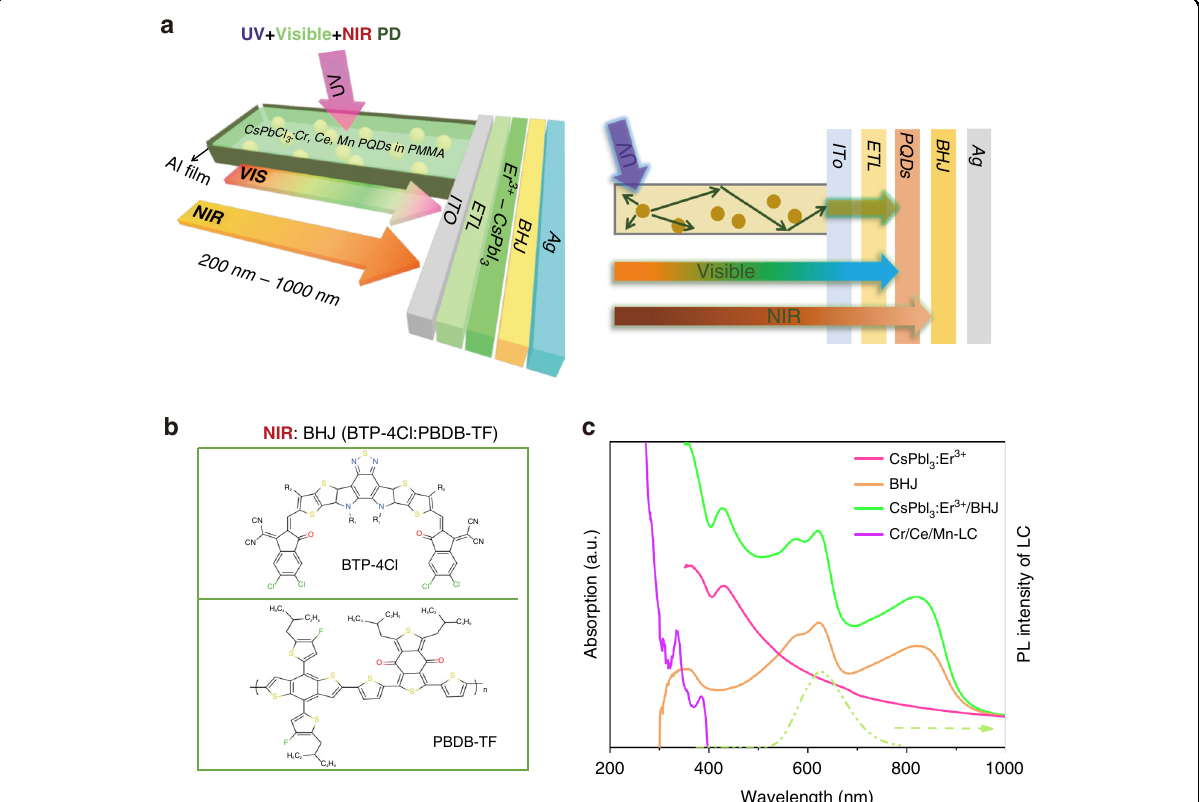
Fig. 1 Broadband photodetection based on Cr/Ce/Mn-LC and BHJ and CsPbI 3 :Er 3 + PQDs. a Schematic device structure and 2D view of a broadband PD. b The molecule structures of BTP-4Cl:PBDB-TF (BHJ). c Absorption spectra of Cr/Ce/Mn-LC and BHJ and CsPbI 3 :Er 3 + PQDs and CsPbI 3 : Er 3 + PQDs/BHJ fi lm, and photoluminescence spectra of